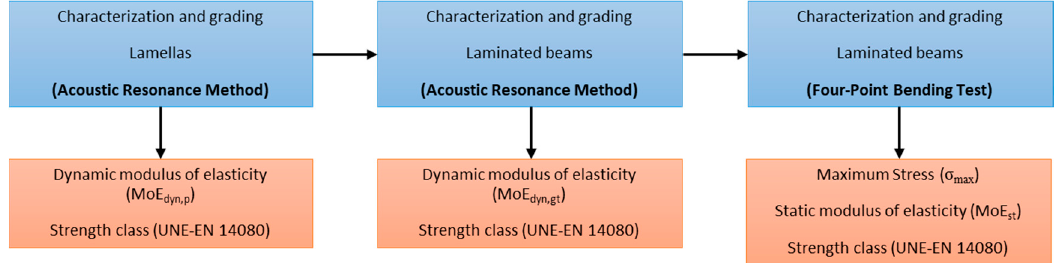
Figure 1. Chart flow of the general experimental procedure. MoE dyn,p : Dynamic modulus of elasticity of planks. MoE dyn,gt : Dynamic modulus of elasticity of glulam timber. σ max: Maximum stress in bending. MoE st : Static modulus of elasticity.